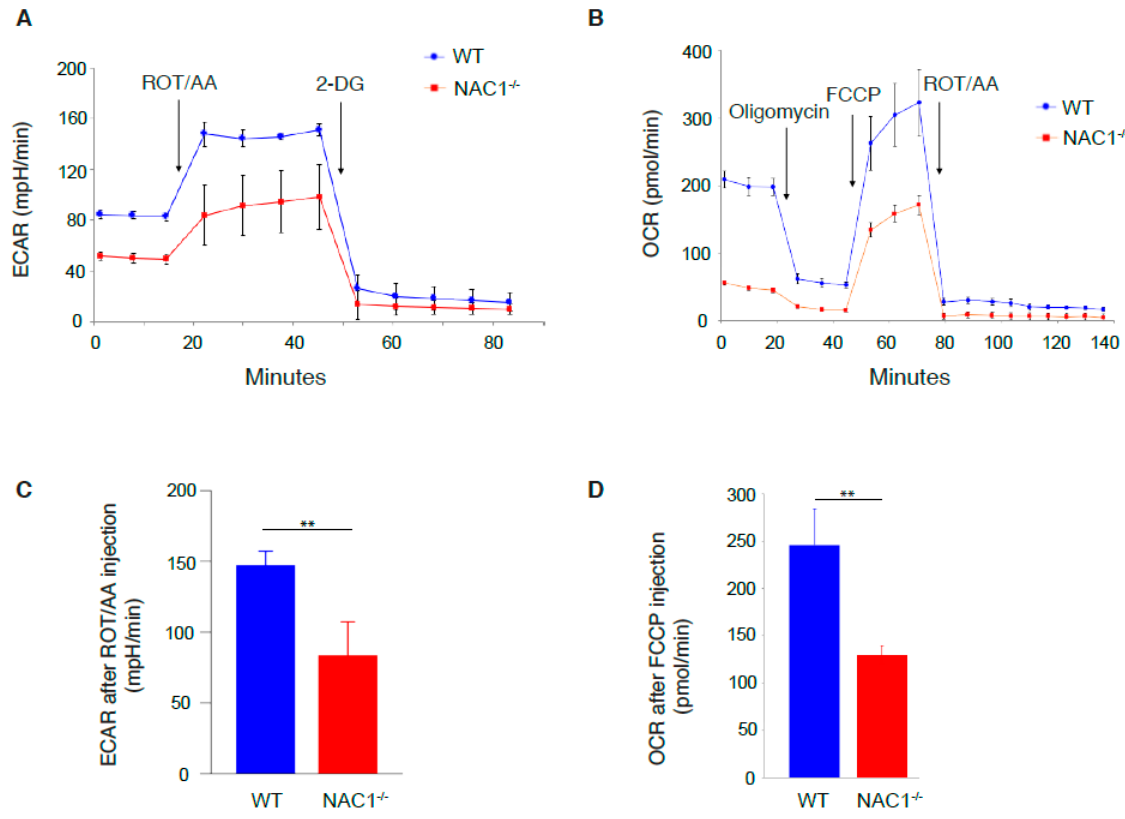
Figure 2. Defects in glycolysis and oxidative phosphorylation rate of NAC1 − / − CD8 + T cells. Cell metabolism was tested using the Agilent Seahorse Assay on day 3 after activation. ( A , C ) The cells were activated with coated anti-CD3 and soluble anti-CD28 Abs. Then, 2 × 10 5 cells were plated in each well of seahorse microplate for glycolytic rate testing. The drugs were injected into each well at the time indicated in the figures. The Extra Cellular Acidification Rate (ECAR) was measured as a proxy for glycolytic rate. The ECAR level after ROT/AA injection was compared between WT and NAC1 − / − groups. Sample numbers ( n = 4), the p -value is 0.0076 ( B , D ). The activated 2 × 10 5 T cells were seeded in a microplate before mitochondrial stress testing. The different drugs were added to the well according to the indicated time points. The Oxygen Consumption Rate (OCR) was tested as a proxy for oxidative phosphorylation. The OCR level was then compared after FCCP injection between the two groups. Sample numbers ( n = 4), p -value is 0.0054 (**, p < 0.01).